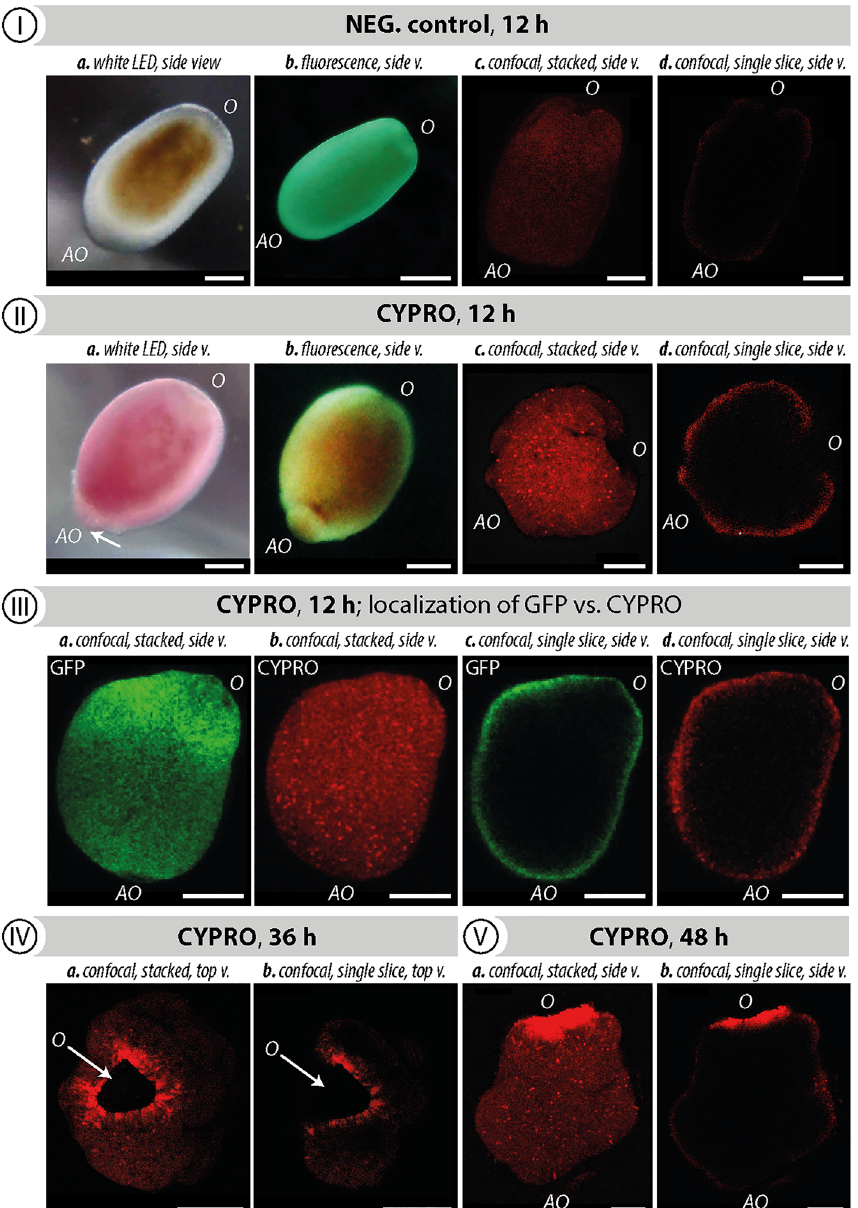
Figure 1. Cycloprodigiosin (CYPRO) uptake by Leptastrea purpurea larvae examined for 48 h in the absence of light. ( I ) Swimming larva without CYPRO (negative control), ( II ) metamorphosing larva 12 h after CYPRO addition (0.2 µg mL −1 ) and ( III ) a location-based comparison between CYPRO in red and green fluorescence protein (GFP) in green, ( IV ) 36 h and ( V ) 48 h after CYPRO addition. Fluorescence emitted by larvae and their symbionts was captured using light microscopy combined with blue light and yellow filters ( I -a,b, II -a,b) and confocal laser scanning fluorescence microscopy ( I -c,d, II -c,d, III -V). Confocal pictures are displayed as stacked (n = 50) and single shots (n = 1 taken from the center of larva). An excitation wavelength of 514 nm and an emission window of 550–570 nm was used for CYPRO detection, while GFPs were visualized by an excitation wavelength of 488 nm and an emission window of 500–520 nm. Scale bars: 250